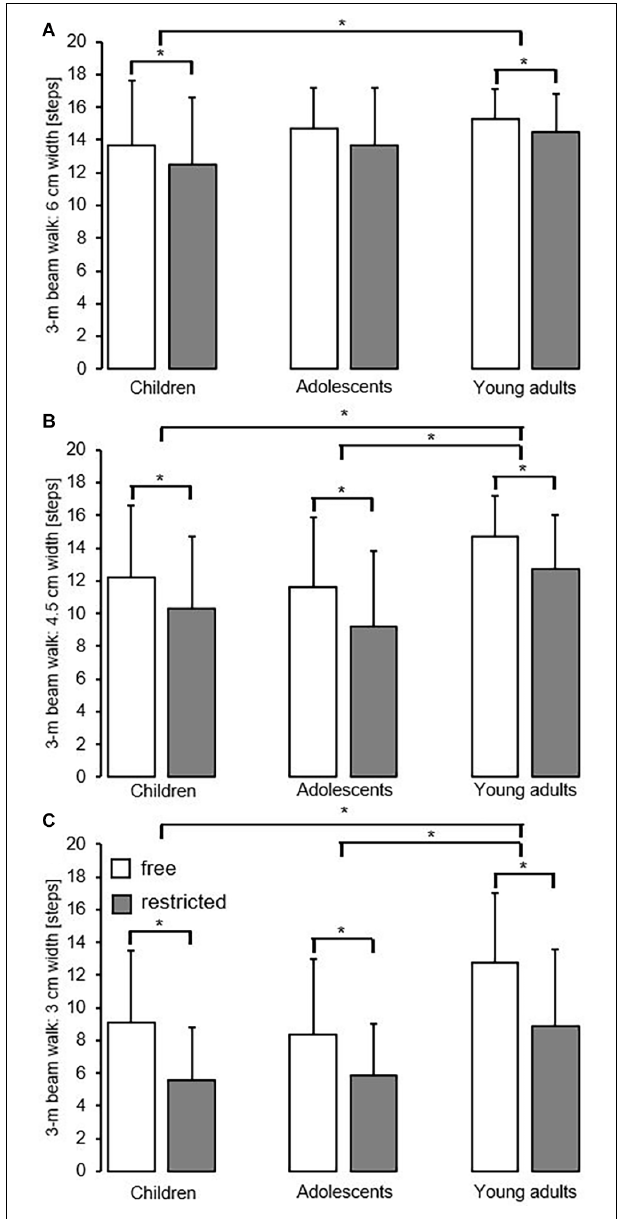
FIGURE 2 | Effect of free vs. restricted arm movement and task difficulty by age group on dynamic balance performance using the 3-m beam walking backward test with a beam width of 6 cm (A) , with a beam width of 4.5 cm (B) , and with a beam width of 3 cm (C) . Values are means ± standard deviations. *Significant difference ( p < 0.05) between free and restricted arm movement conditions and age